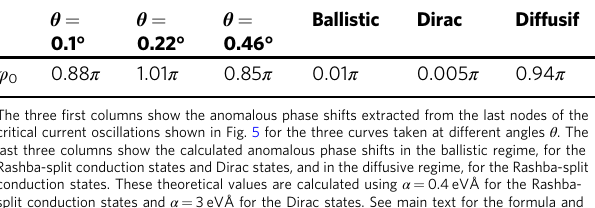
Table 2 Anomalous phase shifts obtained at B ≃ 100 mT, compared to theory